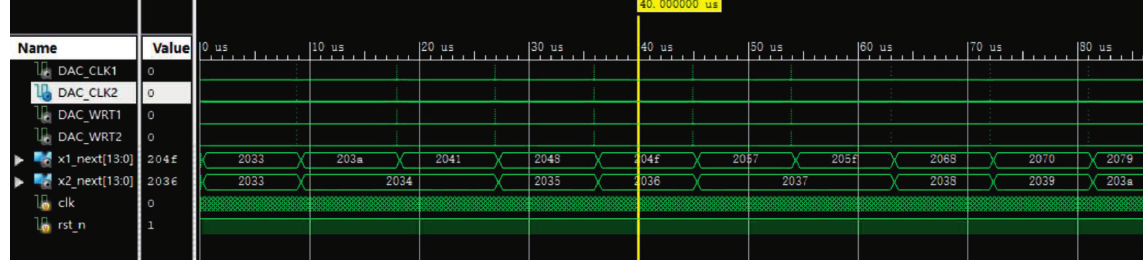
Figure 17: Xilinx ISim simulation results of the modified multistable fourth-order Chua’s chaotic system based on FPGA.